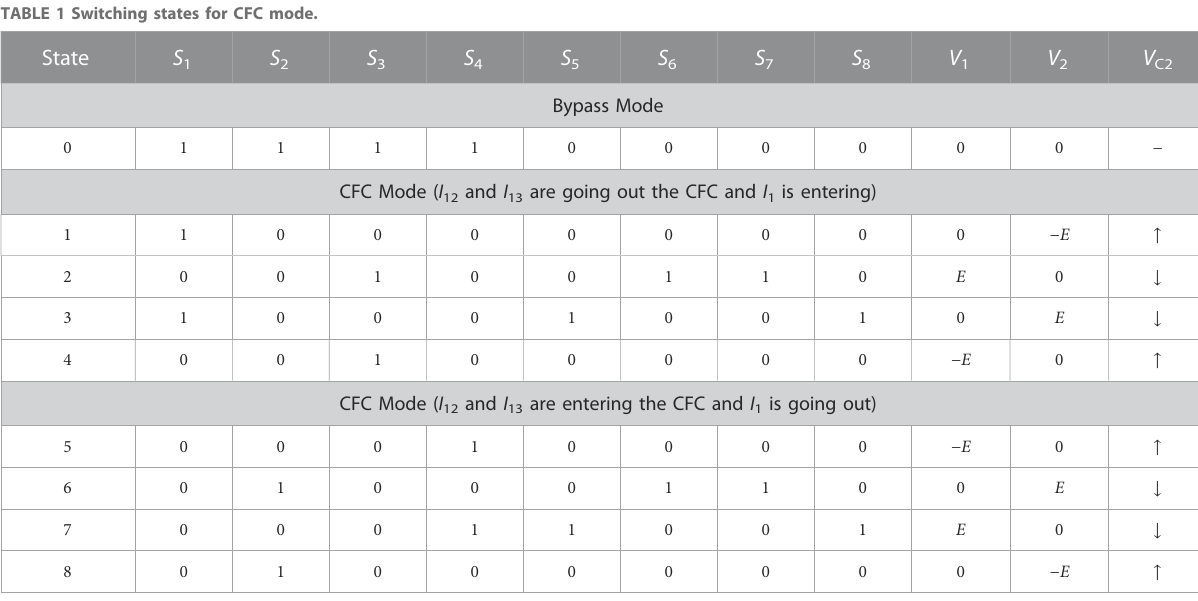
TABLE 1 Switching states for CFC mode.